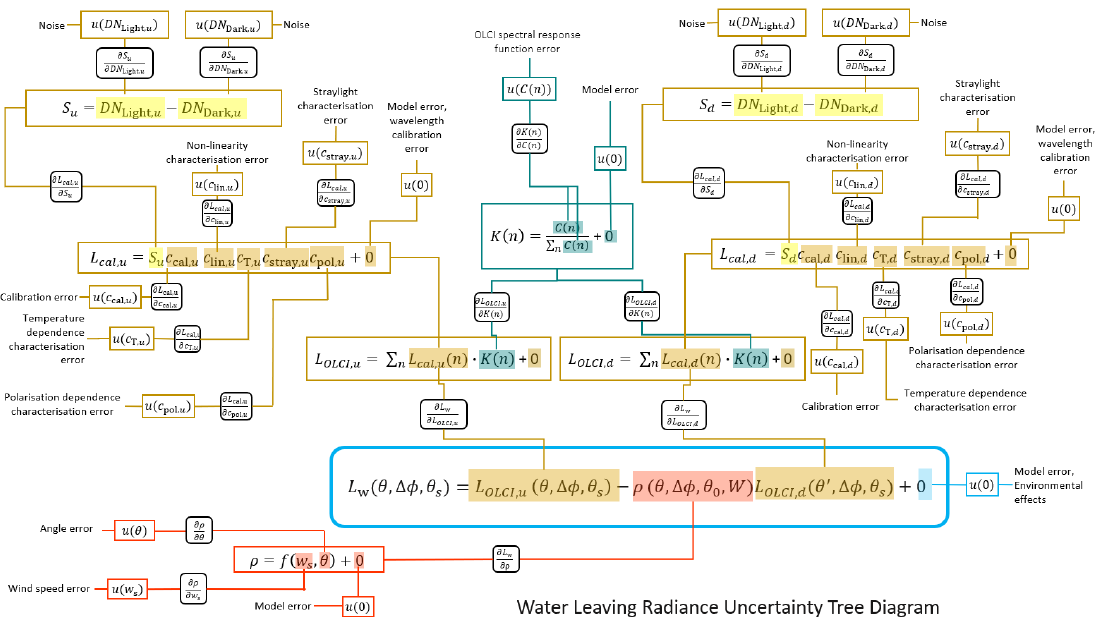
Figure 3. Uncertainty tree diagram for water-leaving